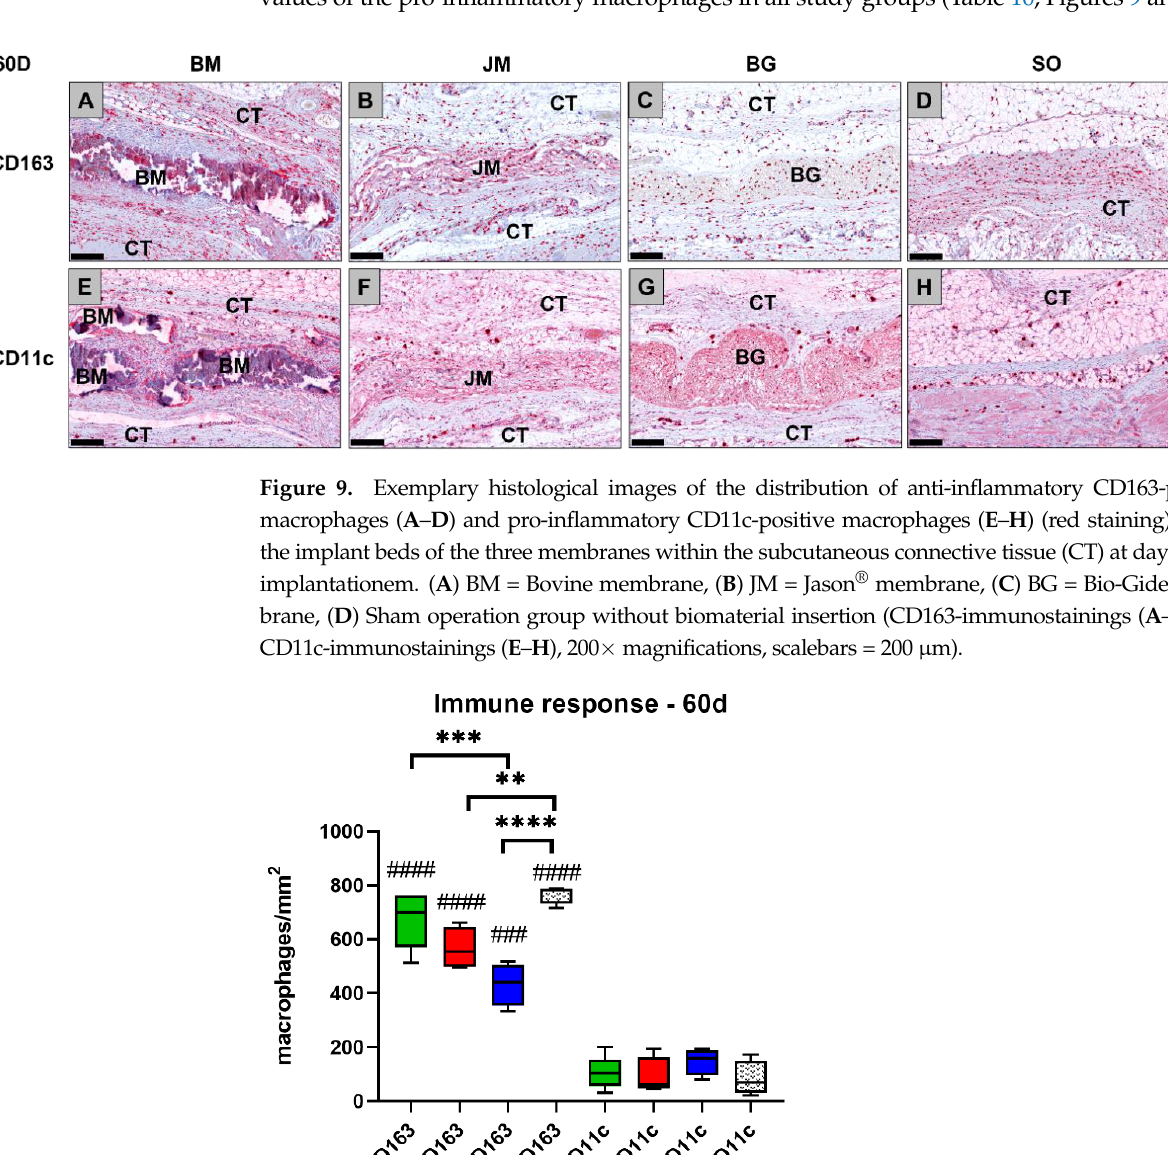
Figure 10. Results of the histomorphometrical measurements of the macrophage distribution at day 60 post implantationem (* = intraindividual differences, # = interindividual differences; ****/####: p < 0.0001, ***/###: p < 0.001 and **: p < 0.01). BM: bovine membrane, JM: Jason ® membrane, BG: Bio-Gide ® , SO: sham operation.